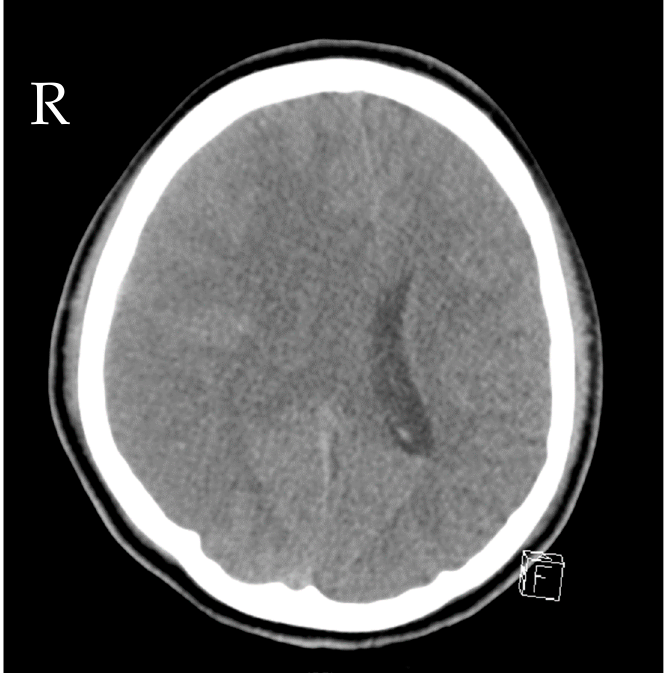
Figure 1. Computed tomography of the head showing cerebral oedema and signs of herniation.